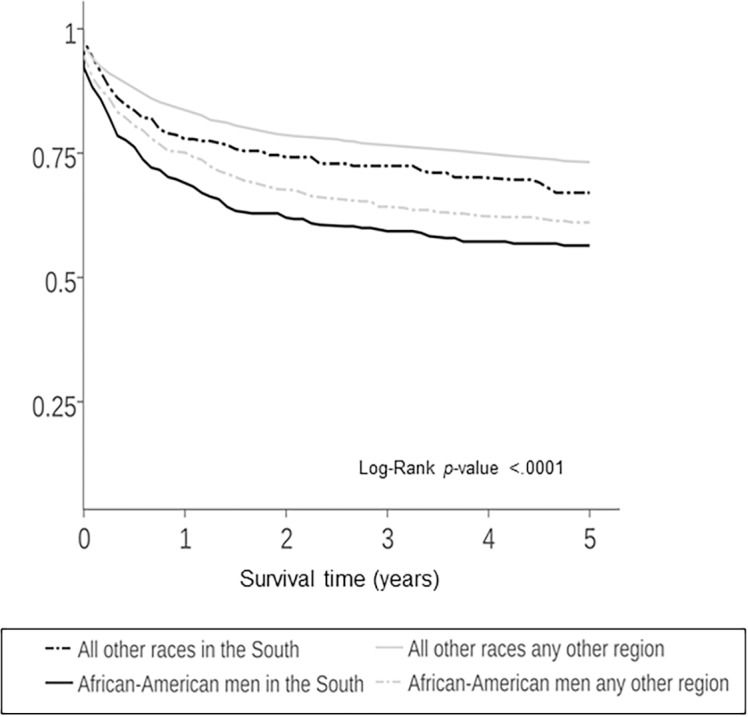
KS survival in the U.S. by Race and Geographic Region, 2000–2013, N = 3,793.